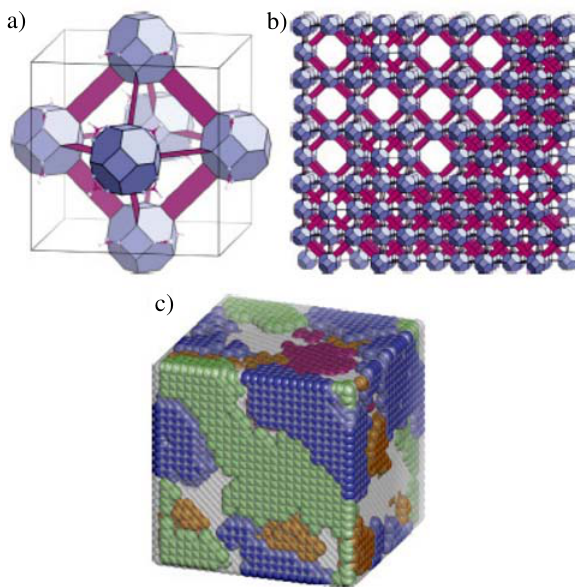
Figure 4 : Structural description of defect nanoregions in Ui- O66(Hf). 79 Reprinted with permission. Copyright Nature Publishing